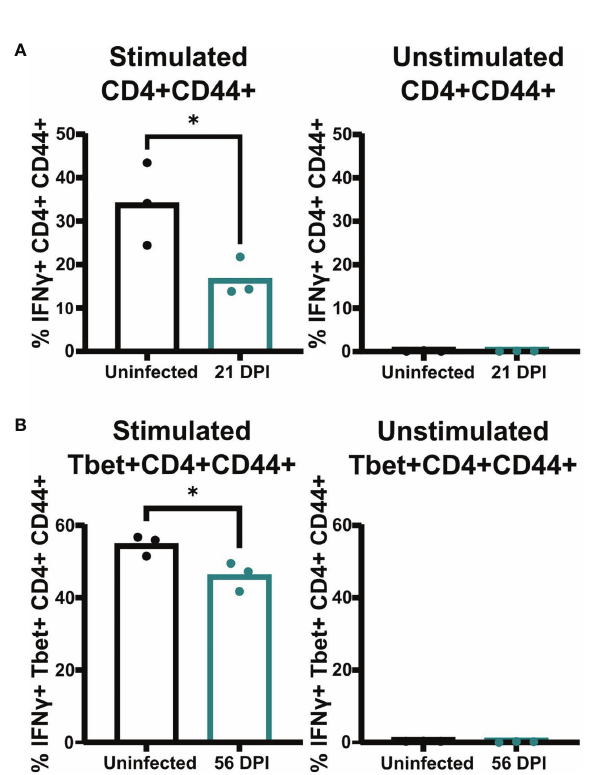
FIGURE 9 | Pulmonary CD4 T-cells isolated from UgCl223 infected mice had diminished IFN g production upon restimulation. (A) The proportion of IFN g + CD4 +CD44+ cells in the total CD4+CD44+ cell population (%). PMA/ionomycin- stimulated CD4+CD44+ (left) and unstimulated CD4+CD44+ (right) cells were isolated from single cell suspensions of lungs harvested from C57BL/6 mice that were intranasally infected with UgCl223 (n=3) at 21-days post-infection versus mice that were uninfected (n=3) and analyzed by fl ow cytometry. (B) The proportion of IFNg+Tbet+CD4+CD44+ cells in the total Tbet+CD4+CD44+ cell population (%). Following cell sorting, Tbet-zsGreen+ cells from UgCl223-infected Tbet-zsGreen FoxP3-RFP mice (n=3) at 56-days post-infection and from uninfected mice (n=3) were stimulated with PMA/ionomycin (left) or were untreated (right), and then analyzed by fl ow cytometry. *p < 0.05 by two-tailed